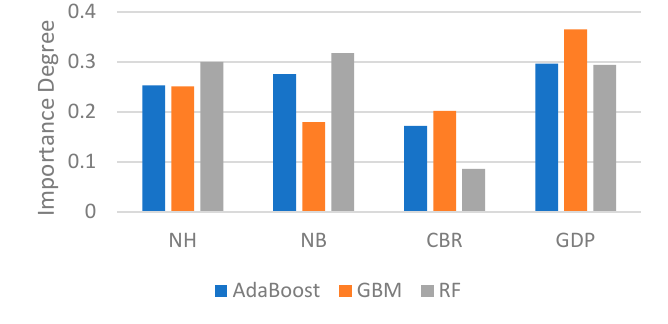
Figure 5. The feature importance of each single ML algorithm.